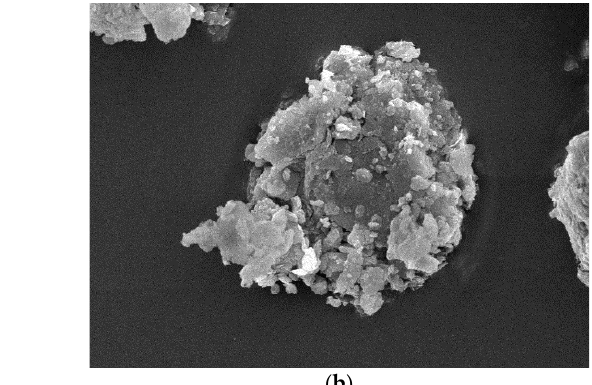
Y.Clay L.Clay Figure 5. Effect of adsorbent dose; Conditions: t = 10 min for Y.Clay/15 min for L.Clay, C = 12 mg/L, T = 30 °C. 3.2.3. Effect of pH Initial pH of dye solution plays an important role in the adsorption and photocata- lytic process, particularly on the uptake capacity or elimination. It was evident that crystal violet adsorption capacity decreases with increase in initial pH (Figure 6). It can also be ob- served that maximum uptake capacity on various adsorbents was obtained at pH 2. This observation indicated that adsorption of crystal violet dye depends on pH. Higher uptake capacity of anionic dye at acidic pH could be attributed to the number of positively active sites on the clay surface. This condition was favorable to adsorption due to electrostatic in- teractions. Further adsorption experiments were conducted at initial pH of 2.0.